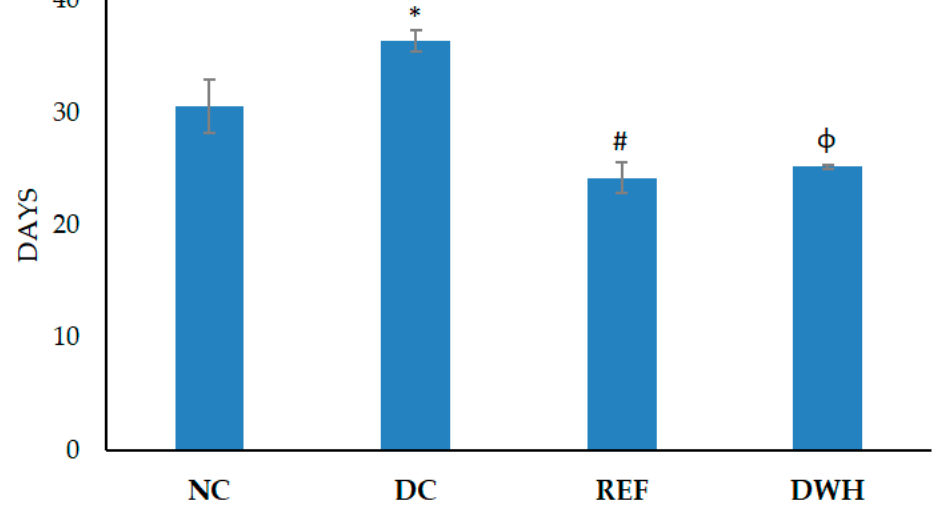
Figure 12. Effect of topical application of 2% Fucidin cream (REF) and 2% DWH (TEST) gel on the epithelialization periods in diabetic rats. Values are expressed as mean ± S.E.M., n =5 rats/group. A * designates the significant difference between NC and DC at p < 0.05. A # designates the significant difference between NC and REF groups at p < 0.05. A ф designates the significant difference between NC and DWH groups at p < 0.05.